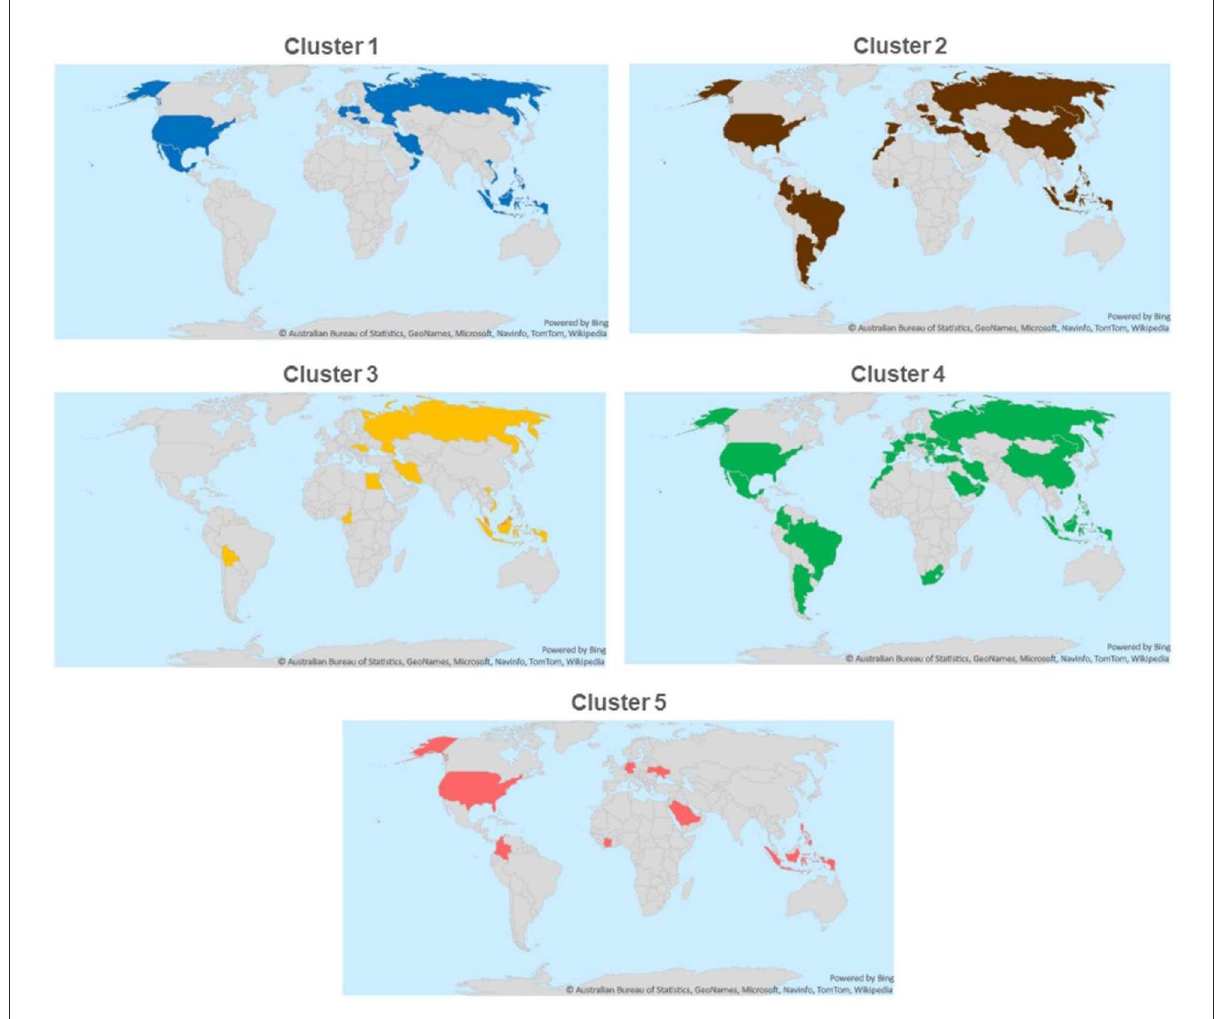
FIGURE3 Geographical distribution of different ARV